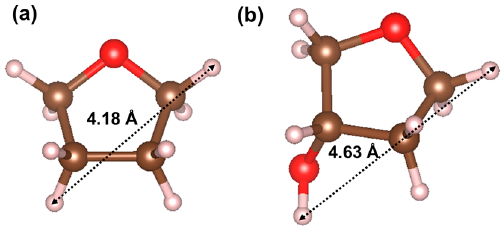
Figure 2. Molecular shapes and the longest end-to-end distances of ( a ) THF and ( b ) 3-OH THF.